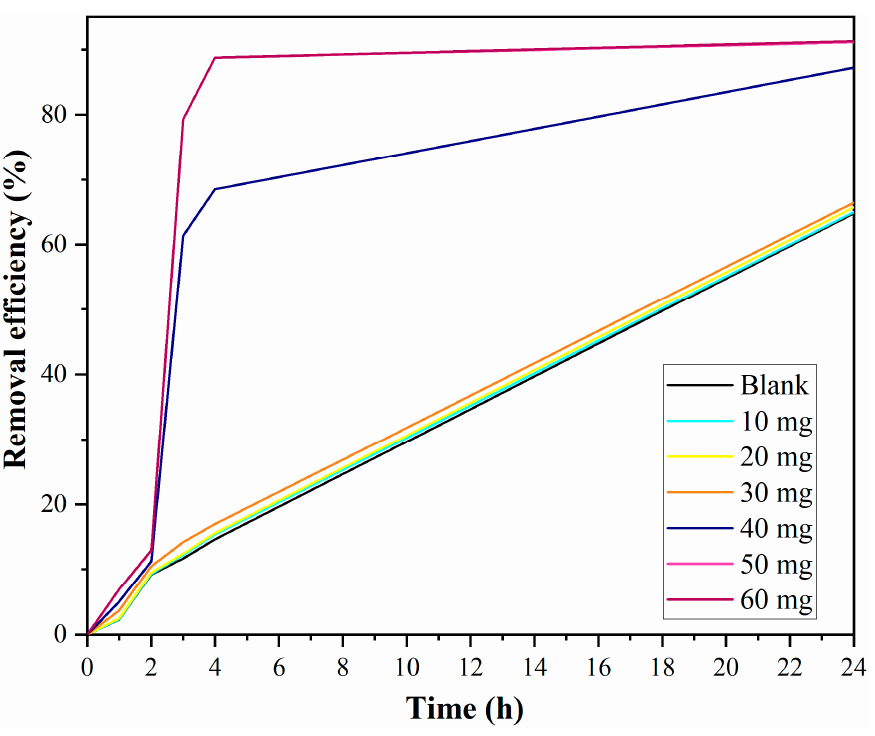
2 O 2 , 9.2 mL acetonitrile